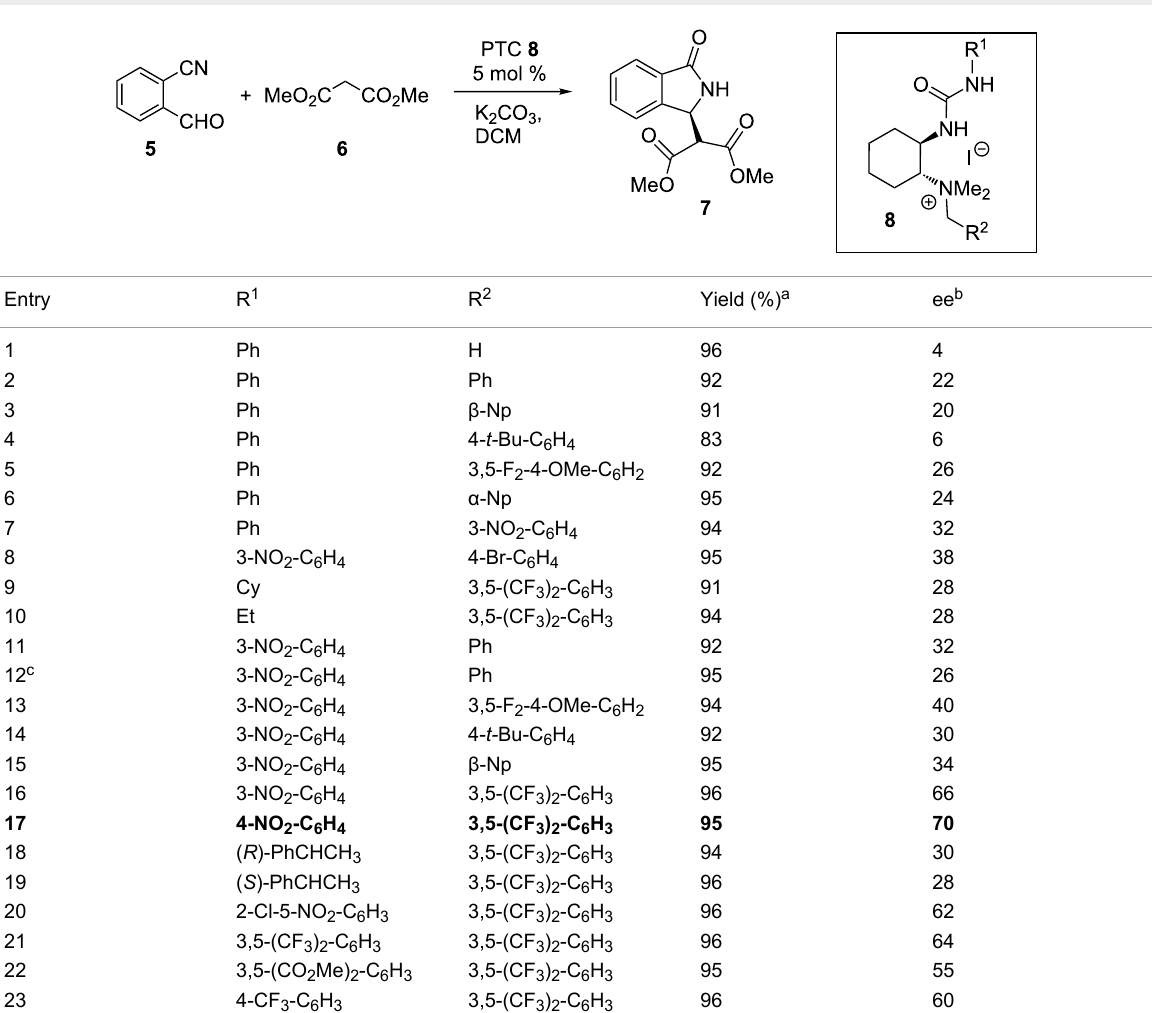
Table 1: Catalyst screening in asymmetric cascade reactions of